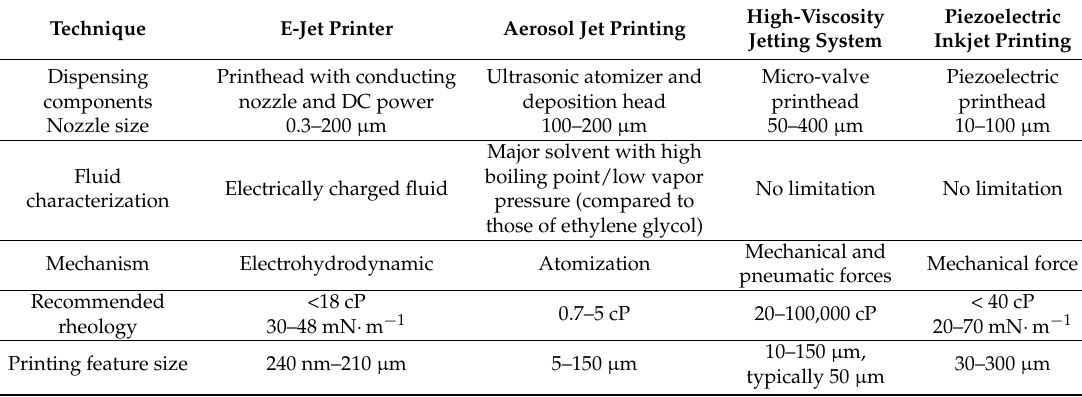
Table 1. Comparison of fluid dispensing approaches for high-resolution applications